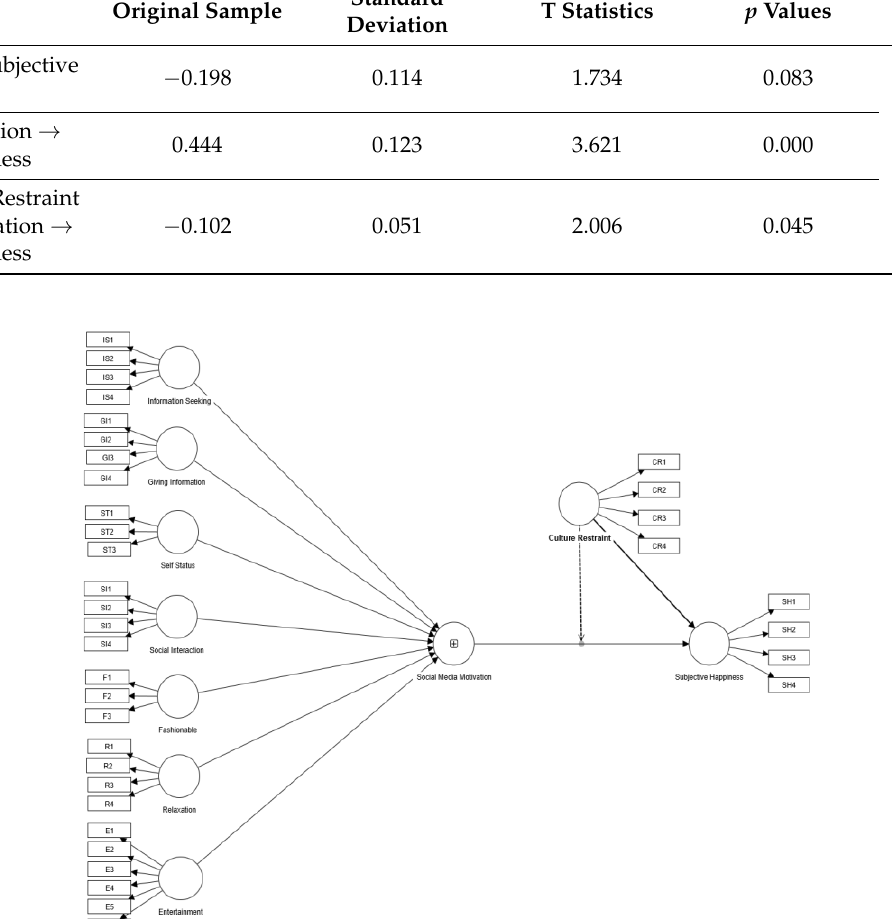
Figure 3. Moderating effect of cultural restraint on the relationship between social media motivation and subjective